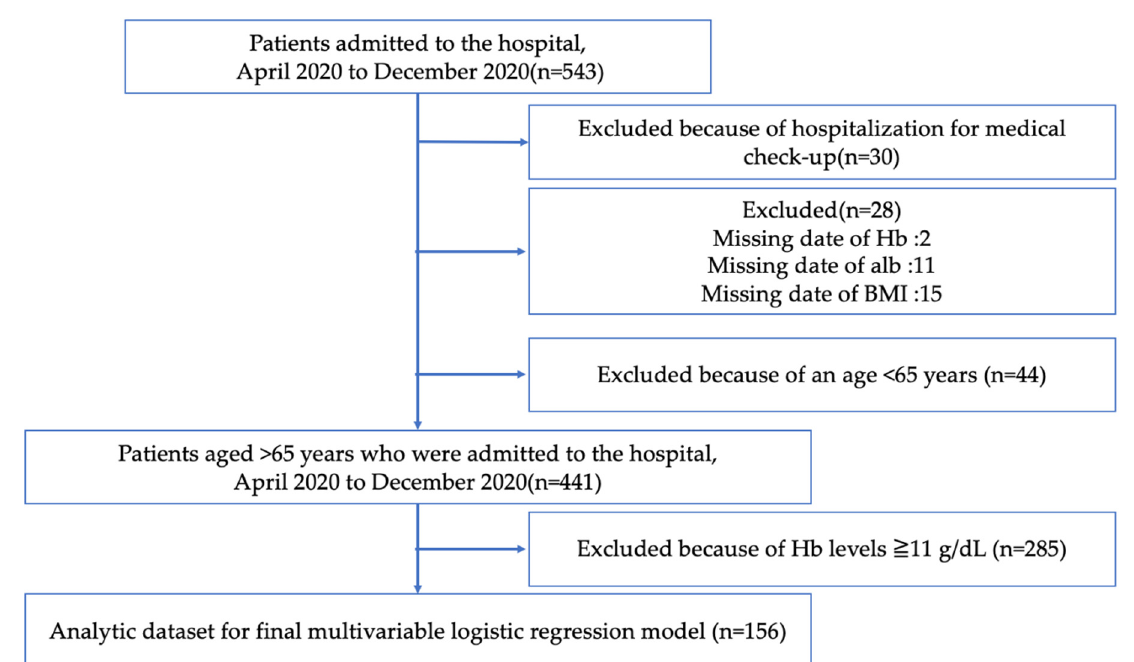
Figure 1. Flowchart of the study population selection process.